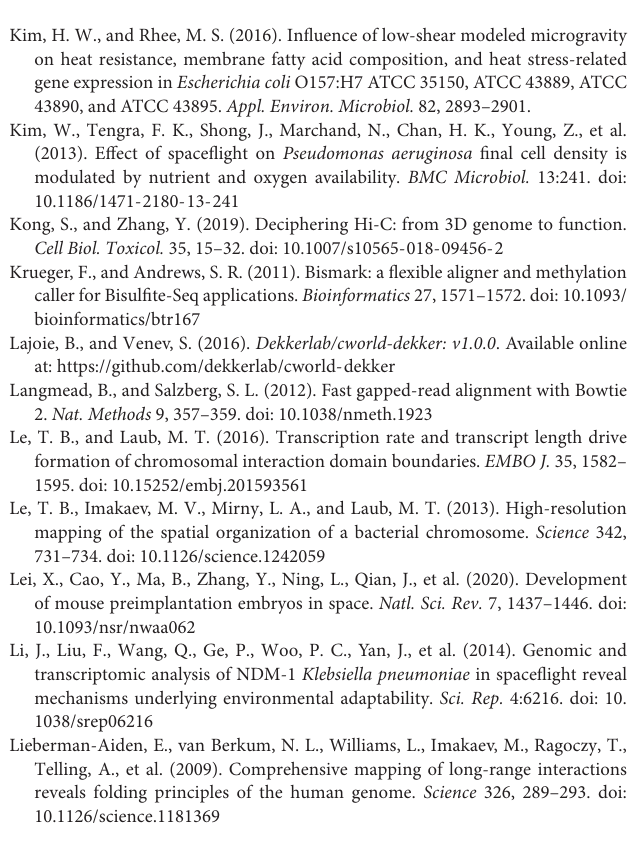
Supplementary Figure 1 | 3D representation of chromosome structure. The color gradient shows the genome coordinates, with blue and red indicating the start and end points of the genome, respectively. Supplementary Figure 2 | Enrichment of DEGs at the CID boundaries of WT. x axes represent ID of CIDs, y axes represent log2 value of DEGs enrichment. Supplementary Figure 3 | DMRs of M1 and M2 compared to WT. The x-axis represents genomic coordinates and y-axis represents the values of methylation difference. Red represents up-regulated DMRs, green represents down-regulated